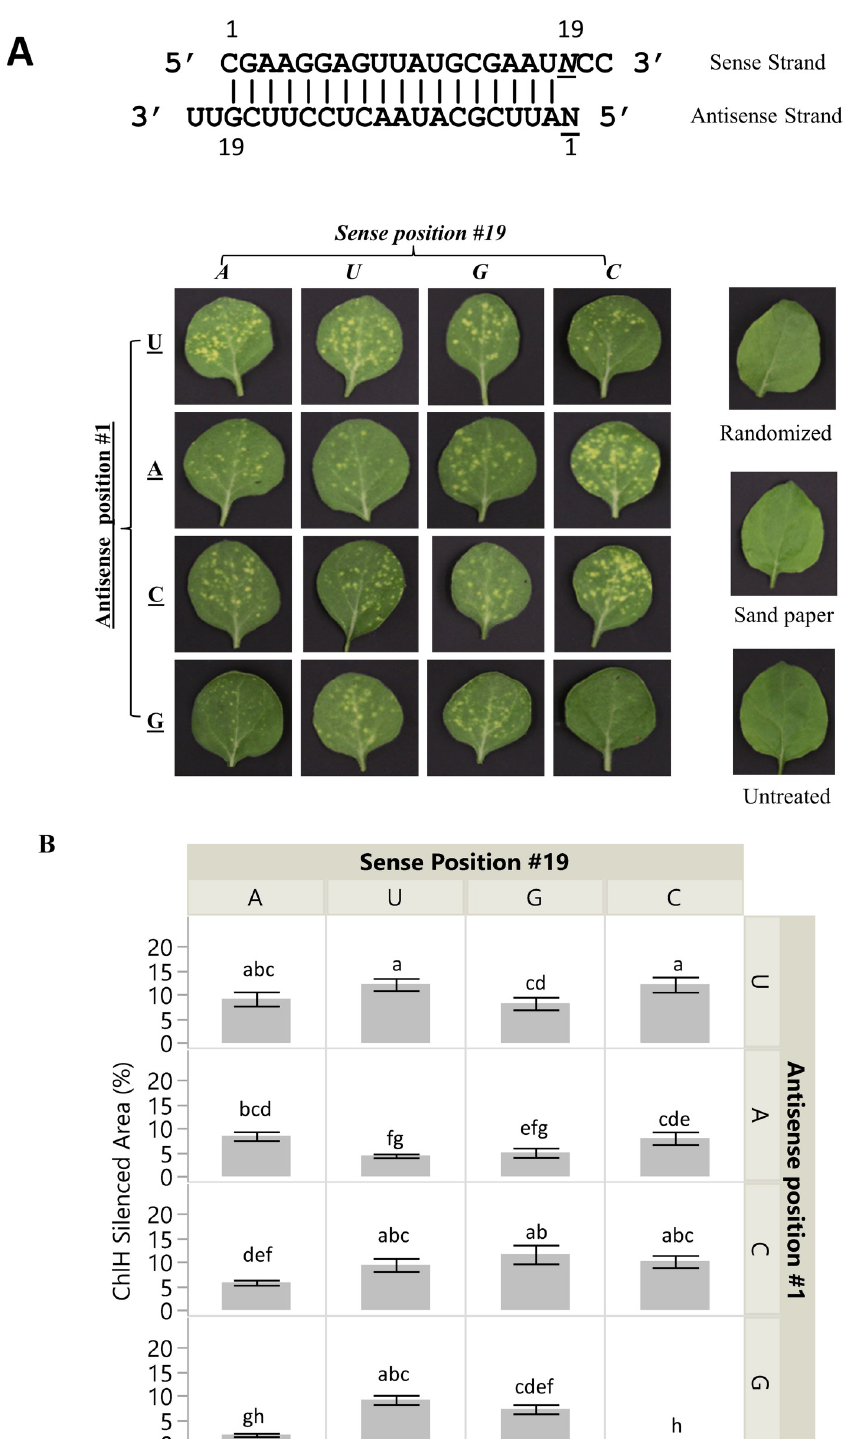
Fig 3. The influence of the 5’ nucleotide of a 21 bp dsRNA on silencing the CHLH gene. A, Each 5’ AS nucleotide was tested both in a paired state and in an unpaired states with all other nucleotide possibilities. Leaves were harvested 4 dpa and photographed under white light. B, Phenotypic area was quantified and expressed as percent of the treated leaf area. Means not followed by the same letter indicate statistical significance ( α = 0.05).